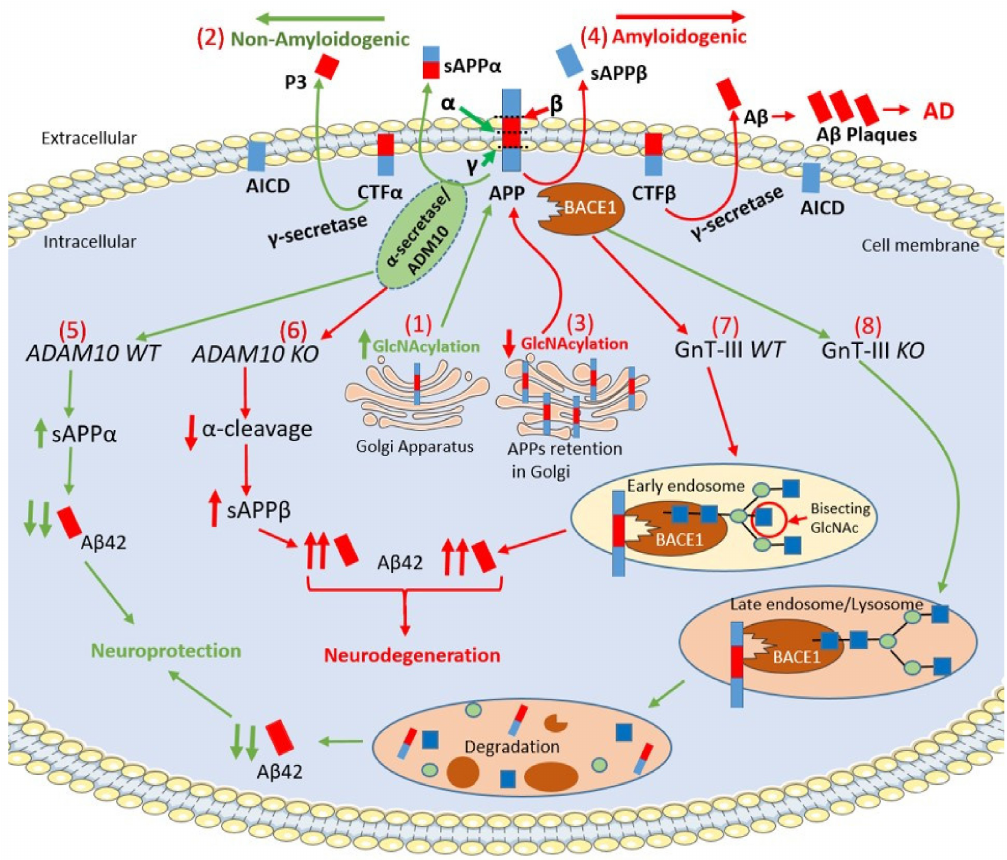
Figure 2. Schematic representation of APP intracellular maturation and its cleavage by secretases. (1) β -Amyloid precursor protein (APP) undergoes glycosylation in the Golgi apparatus and, then, translocates to cell membrane for secretase cleavage (2) The increase of APP glycosylation drives toward the non-amyloidogenic pathway. α -secretase cleaves APP within the β -Amyloid (A β ) sequence producing the C-terminal fragment α (CTF α ) and soluble N-terminal fragment α (sAPP α ), which has neuroprotective properties. Afterwards, γ -secretase cleaves CTF α into N-terminal fragment (P3) and a soluble APP intracellular domain (AICD). (3) The pharmacological inhibition of APP glycosylation retains the protein in the Golgi apparatus preventing its transport to cell membrane. The reduction of the glycosylation process drives the amyloidogenic pathway. (4) In the amyloidogenic pathway, β -secretase cleaves APP producing soluble N-terminal fragment β (sAPP β ) and membrane bound C-terminal fragment β (CTF β ). Then, γ -secretase processes CTF β into AICD and A β 42, which forms extracellular A β plaques. (5) α -secretase is a member of ‘a disintegrin and metalloprotease’ (ADAM) family and, in particular, ADAM10 cleaves APP increasing the levels of sAPP α leading to neuroprotection. (6) The genetic deletion of ADAM10 suppresses the α -cleavage of APP, decreases in sAPP α levels and increases A β 42 formation in ADAM10 knockout (KO) mice ( Adam10 − / − ). (7) β -site APP cleaving enzyme-1 (BACE1) contains N-glycans, which are further modified by a glycosyltransferases, namely β 1,4-N-acetylglucosaminyltransferase (GnT-III) that is encoded by the Mgat3 gene. In GnT-III WT mice ( Mgat3 +/+ mice), BACE1 localizes in early endosomes and is modified by GnT-III to bear bisecting GlcNAc generating A β 42 elevation. (8) In contrast, in GnT-III knockout (KO) mice (Mgat − / − mice), BACE1 is relocated to late endosomes / lysosomes where BACE1 is degraded leading to a decrease of A β 42 levels. (Red / green up arrows: Increase; Red / green down arrows: